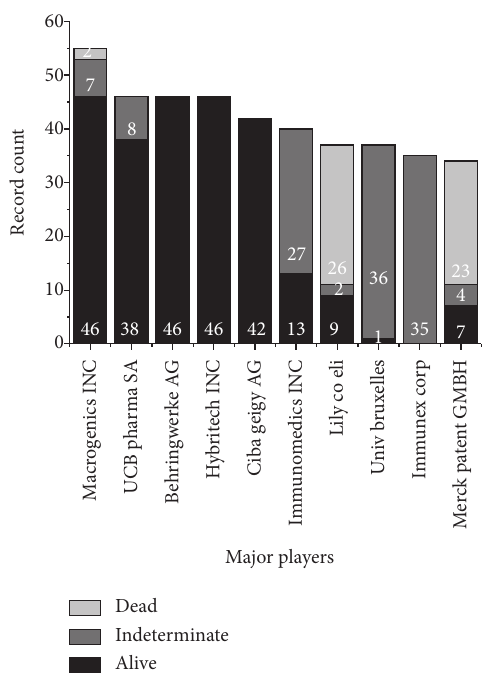
Figure 6: Major players related to the number of